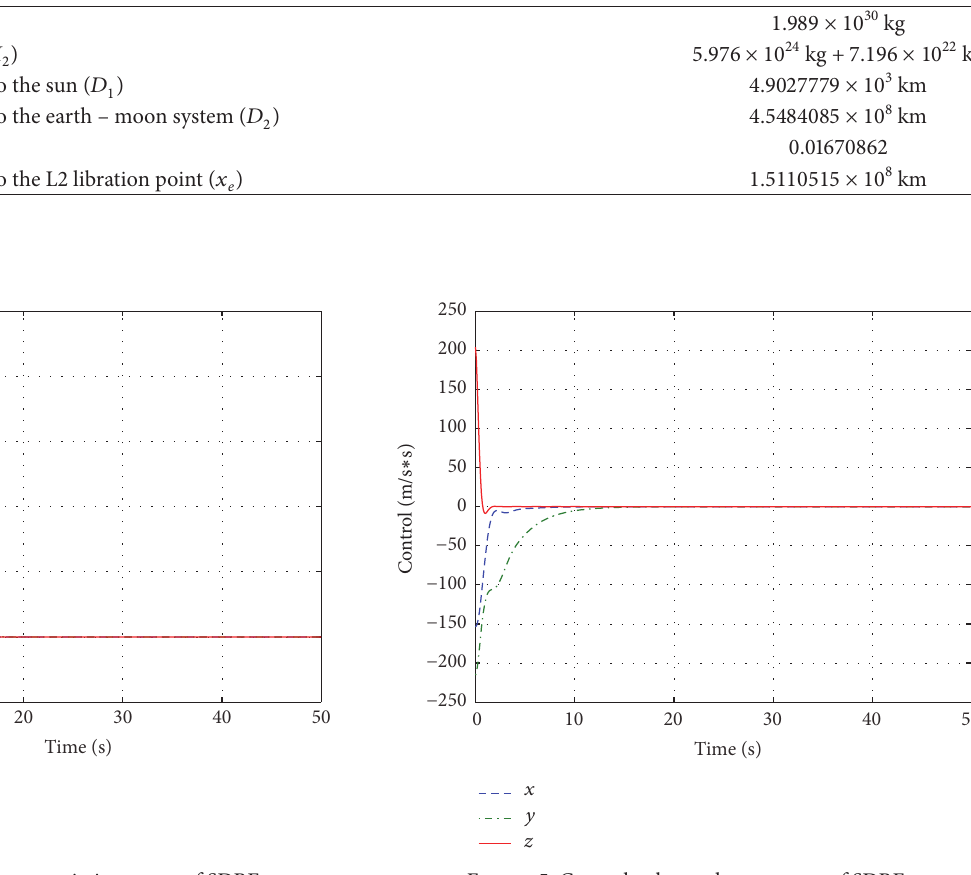
Figure 5: Control volume change curve of